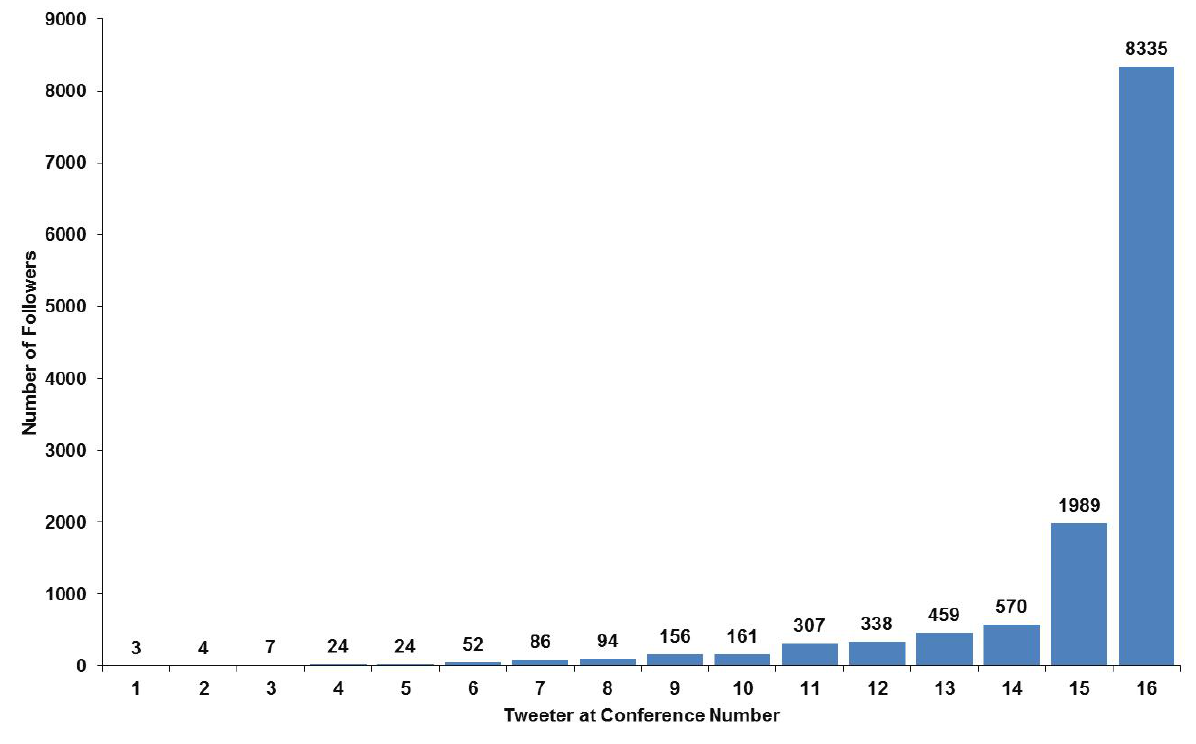
Figure 1. The number of people following each of the 16 people who tweeted at the January 2012 Association of Anaesthetists of Great Britain and Ireland (AAGBI)